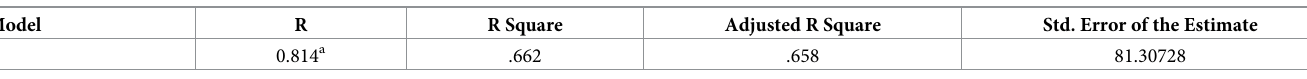
Table 13. Model summary. Model